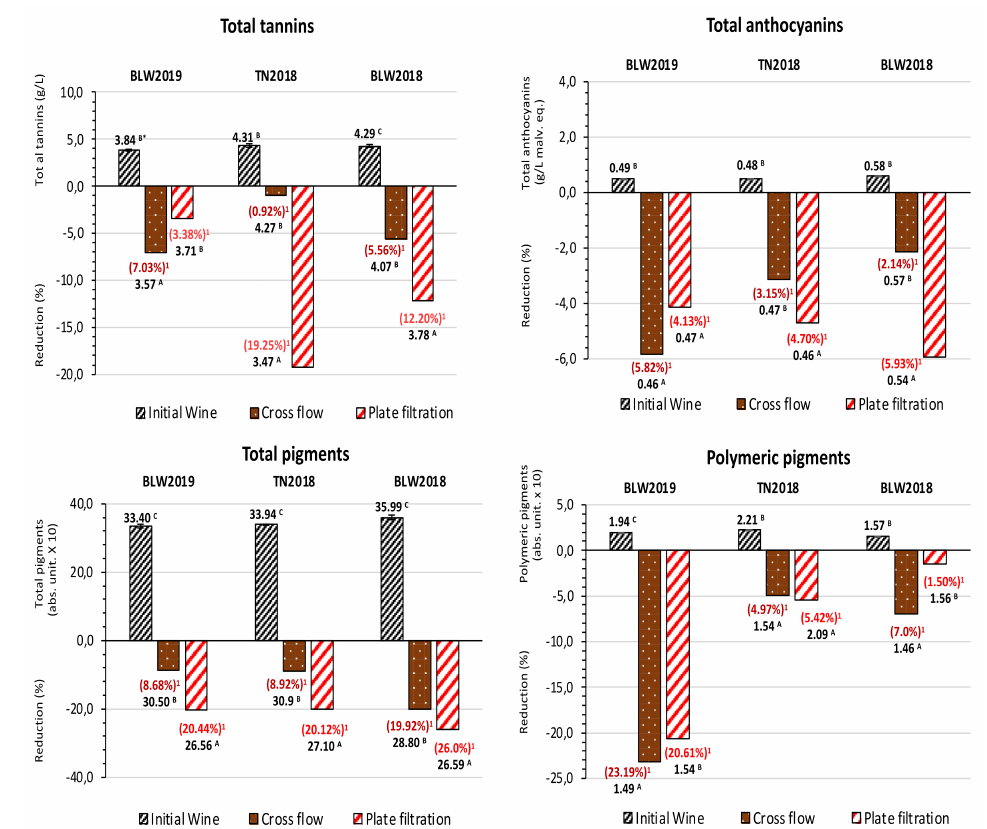
Figure 3. The impact of the two different filtration techniques on the total tannin, anthocyanin, pigment and polymeric pigment variation values for the three red wines studied. TN2018, the red wine produced from the Touriga Nacional grape variety in 2018; BLW2018, the red wine produced from a blend containing Touriga Nacional, Tinta Roriz, Alfrocheiro and Jaen grape varieties in 2018; BLW2019, the red wine produced from a blend containing Baga and Tinta Pinheira grape varieties in 2019. 1 The percentage of reduction in relation to the unfiltered wine. * The average values with the same letter and for the same red wine are not significantly different (Tukey test, p <